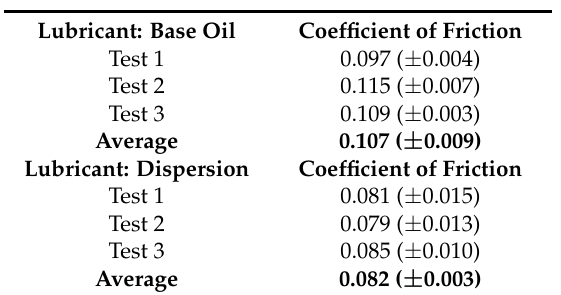
Table 1. Average values and standard deviations (in brackets) of the coefficient of friction across three tests.